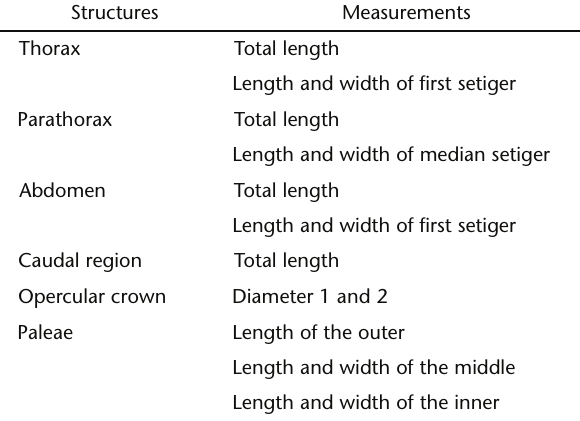
Table I. Measurements obtained in each portion of the body of P. caudata for the morphometric study. Structures